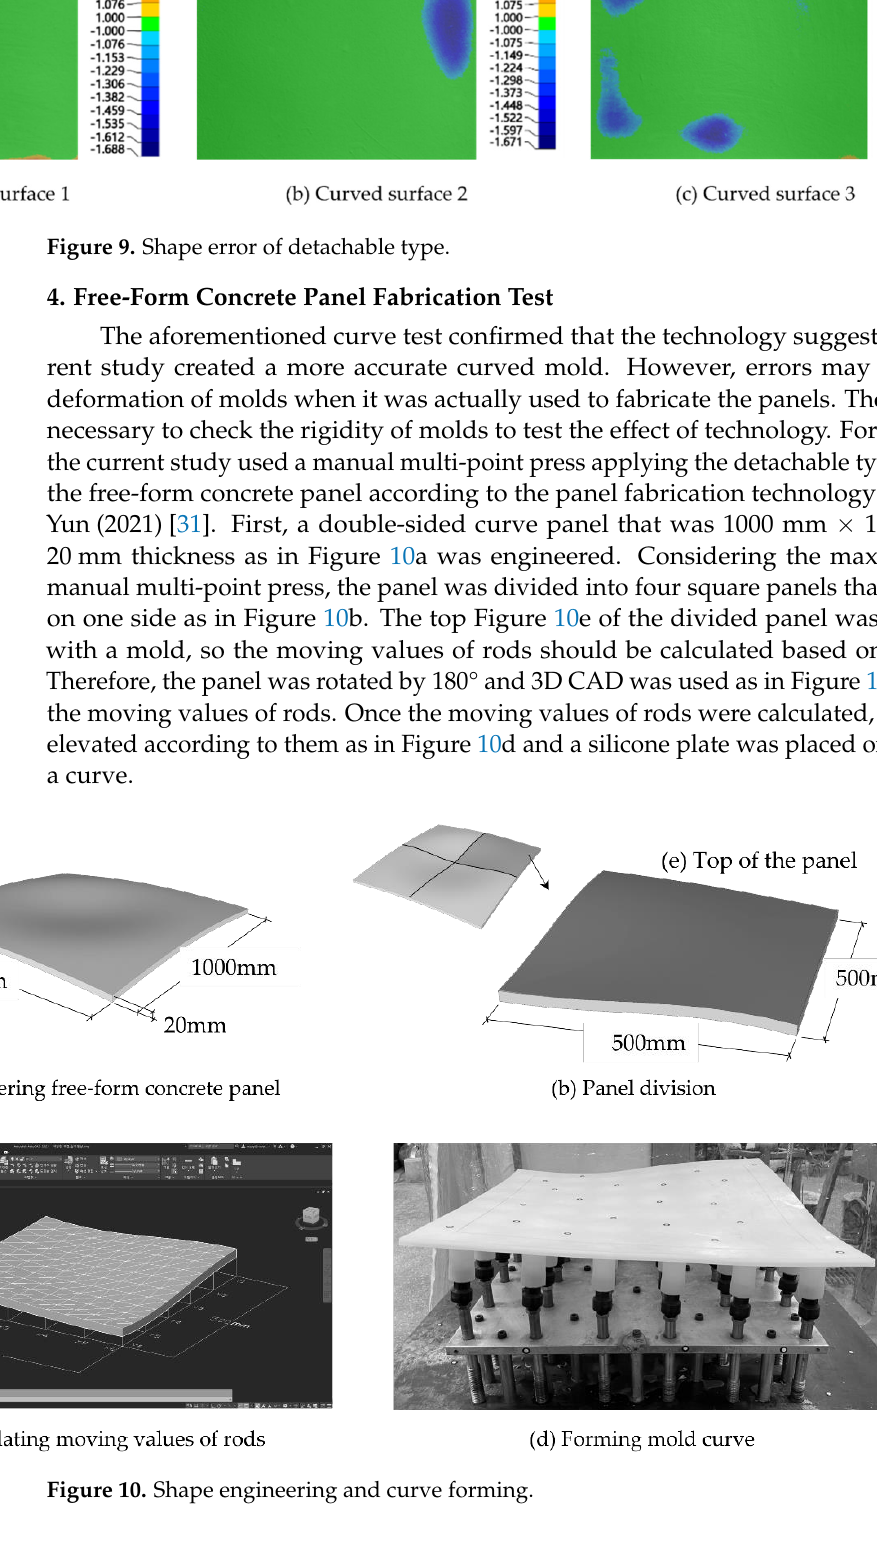
Table 3. Moving values of rods of double-sided curve.